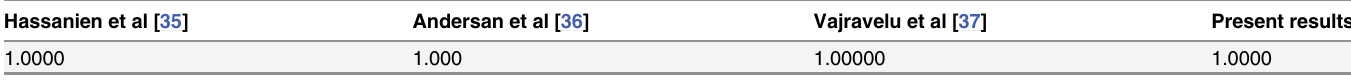
Table 2. Comparison of − f @ (0) when γ = 0, λ = 0 and β = 0 (i.e., for Newtonian fl uid without mixed convection over a fl at plate).